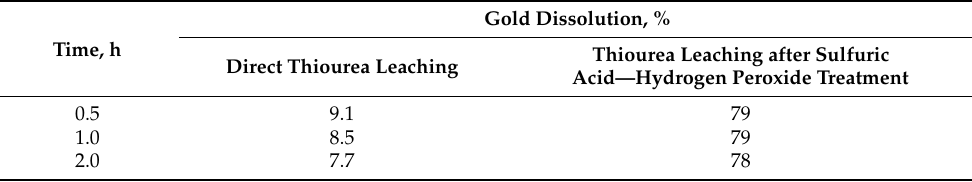
Table 5. Gold dissolution as a function of time with direct thiourea leaching (no preliminary treat- ment) and after preliminary treatment with H 2 SO 4 /H 2 O 2